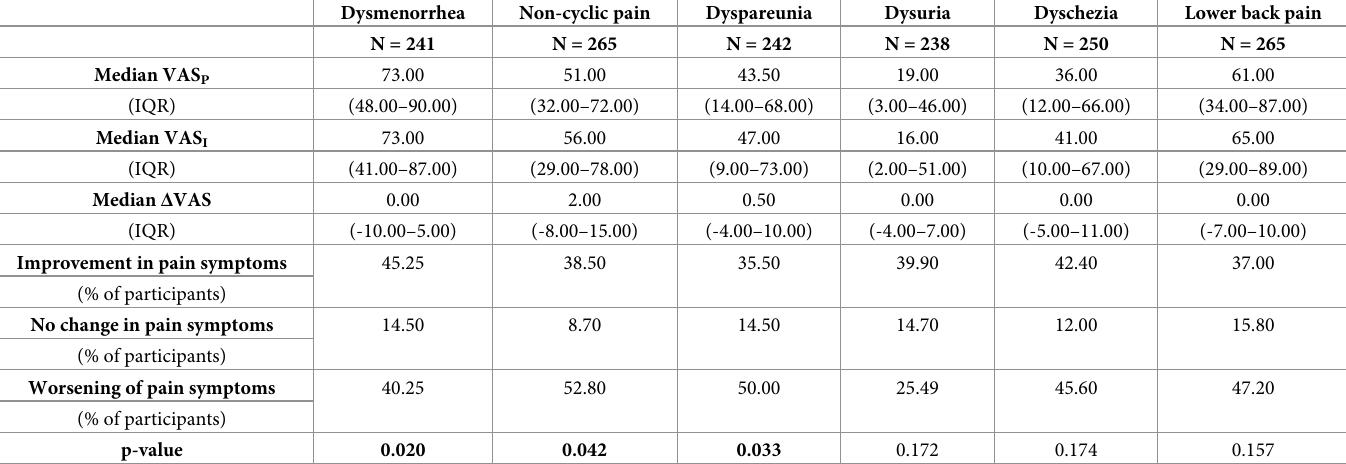
Table 2. Sensitivity analyses of differences of pain intensity ( Δ VAS) during social isolation or quarantine (VAS I ) and previous to social isolation or quarantine (VAS P ) after removing the